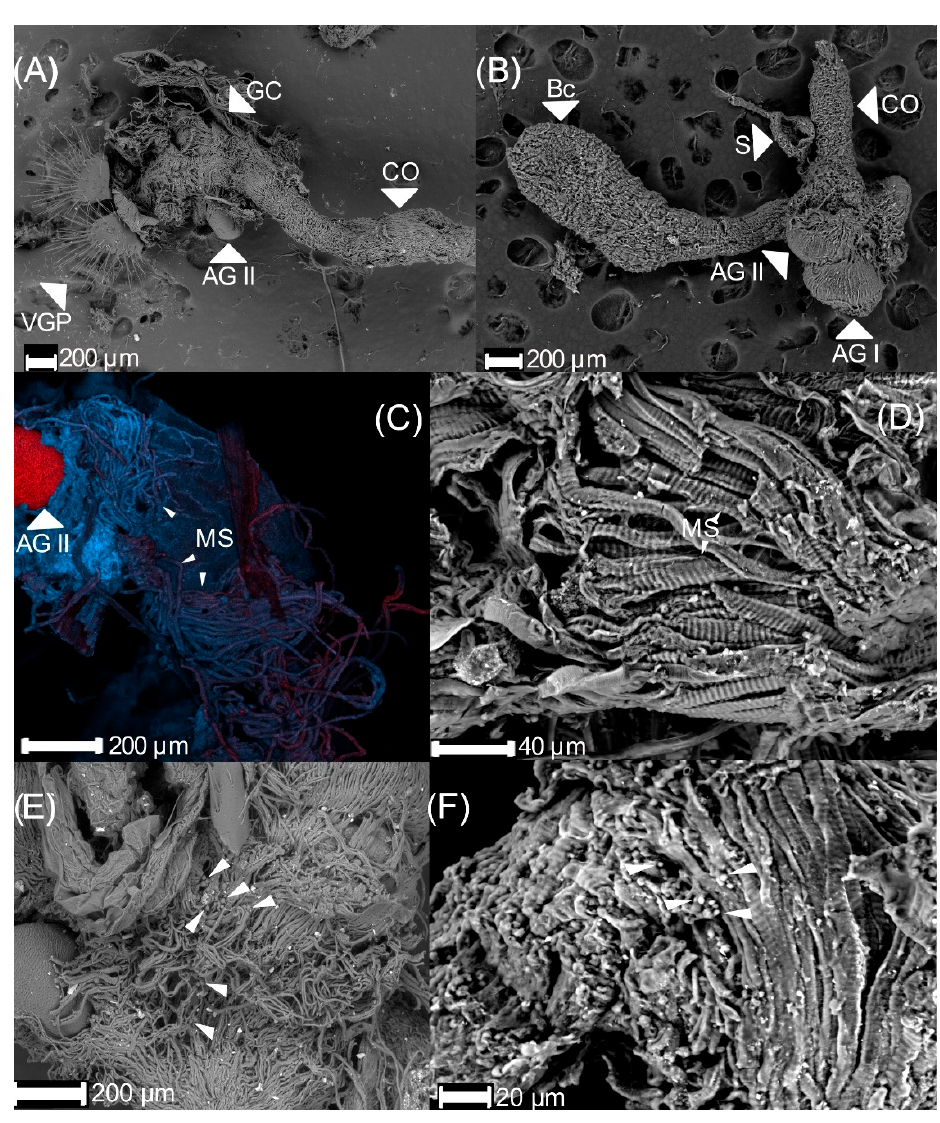
Figure 6. Genital chamber of 18 d old virgin Cyclocephala barrerai female: ( A ) genital chamber (interior view), ( B ) genital chamber (exterior view), ( C ) muscular structure of genital chamber (confocal scanning laser microscopy view), ( D ) cross-section, ( E ) bacteria in the genital chamber (white arrows), ( F ) bacteria into the muscular structure of the genital chamber (white arrows). GC = genital chamber, CO = common oviduct, AG = accessory glands type II, VGP = ventral genital plates, MS = muscular structures.